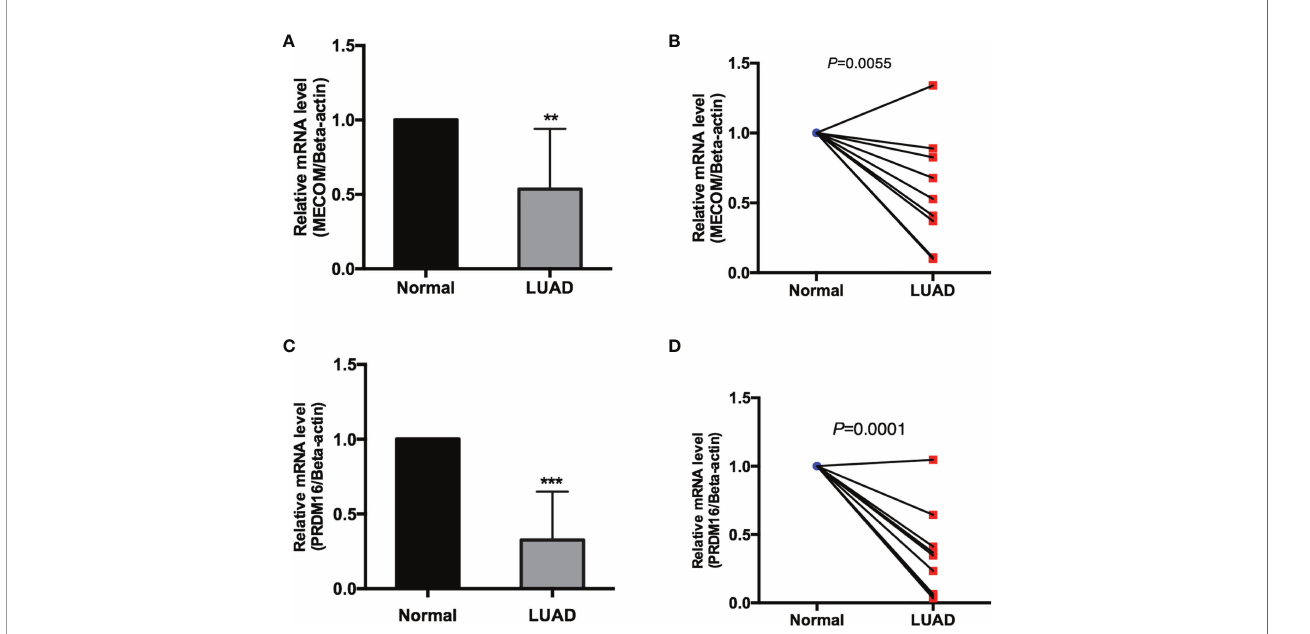
FIGURE 13 | The mRNA expression of MECOM (A, B) and PRDM16 (C, D) in clinical samples of LUAD. MECOM, MDS1 and EVI1 complex locus, also called PRDM3; PRDM16, PR domain containing 16, also called MEL1; LUAD, lung adenocarcinoma. **p < 0.01; ***p <